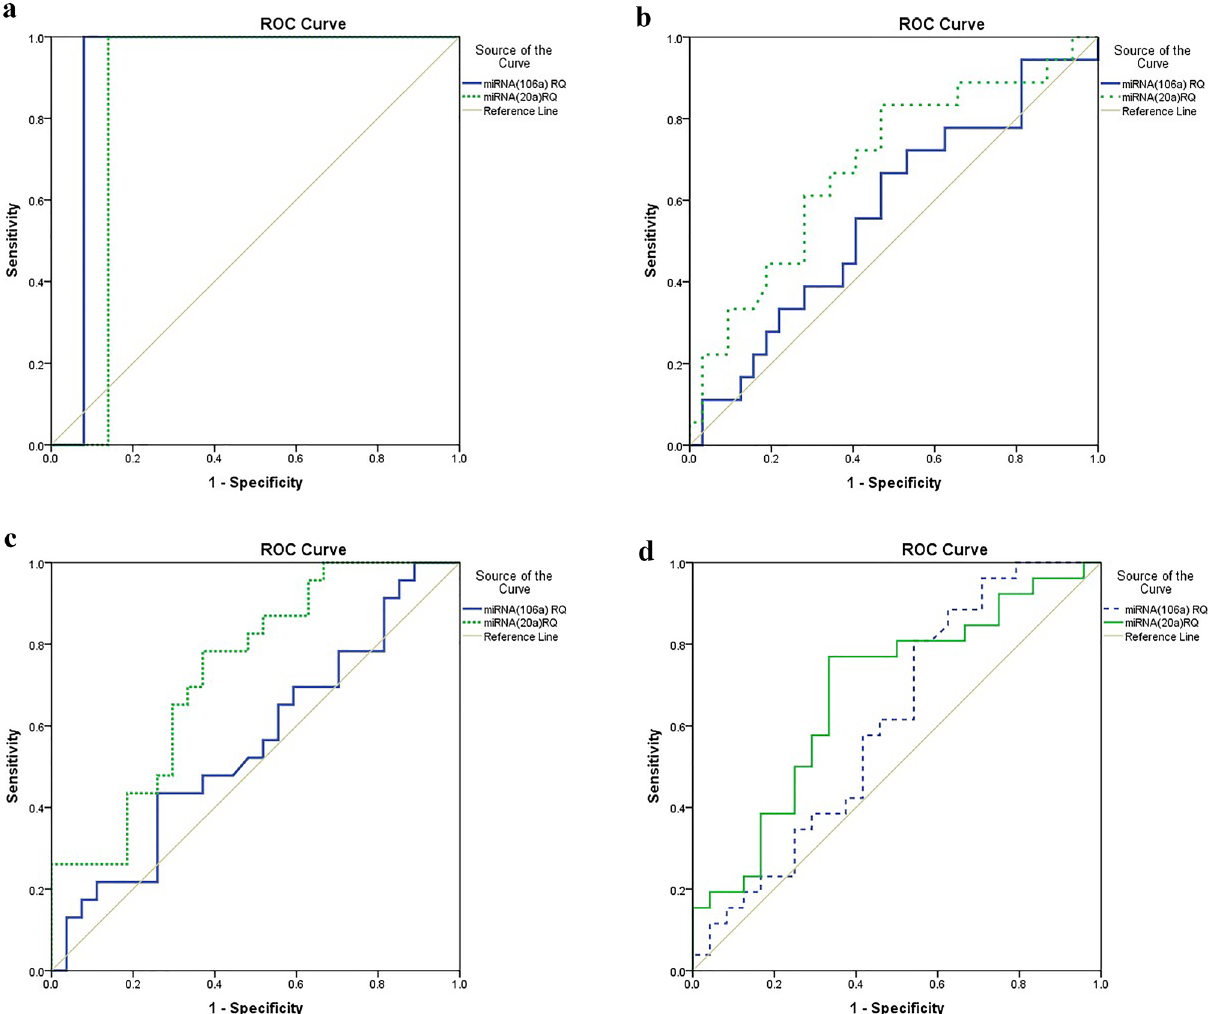
Figure 2. ( a ) ROC curve analysis of miRNAs of patients versus controls. Serum miRNAs as diagnostic biomarkers discriminating COVID-19 patients from healthy controls. MiRNA-106a and MiRNA-20a showed good discriminating efficiency. MiRNA-106a was downregulated in patients with AUC of (0.92 ± 0.03 p = 0.0001**). MiRNA-20a was downregulated in patients with AUC of (0.86 ± 0.04 p = 0.0001**). SPSS software version 22 was used. ( b ) ROC curve analysis for the accuracy of the association between the expression level of serum miRNAs and lymphopenia in COVID-19 patients.Serum miRNA-106a and miRNA-20a as diagnostic biomarkers to identify patients with lymphopenia compared to patients with normal lymphocytic count. MiRNA-20a showed good discriminating efficiency with AUC = (0.68±0.08, p = 0.03*), while miRNA-106a showed no discriminating efficiency with AUC = (0.54±0.08, p = 0.4). SPSS software version 22 was used. ( c ). ROC curve analysis for the accuracy of the association between the expression level of serum miRNAs and the chest CT severity score (CSS) in COVID-19 patients. Serum miRNA-106a and miRNA-20a as diagnostic biomarkers for patients with CSS >19 compared to patients with CSS >19. MiRNA-20a showed good discriminating efficiency with AUC = (0.73±0.07, p = 0.005*), while miRNA-106a showed no discriminating efficiency with AUC = (0.55±0.08, p = 0.5). SPSS software version 22 was used. ( d ) ROC curve analysis for the accuracy of the association between the expression level of serum miRNAs and O2 Saturation. Serum miRNA- 106a and miRNA-20a as diagnostic biomarkers for patients with O2 Saturation > 90% compared to patients with O2 Saturation < 90%. MiRNA-20a showed good discriminating efficiency with AUC = (0.68±0.07, p = 0.02*), while miRNA-106a showed no discriminating efficiency with AUC = (0.61±0.08, p = 0.1). SPSS software version 22 was